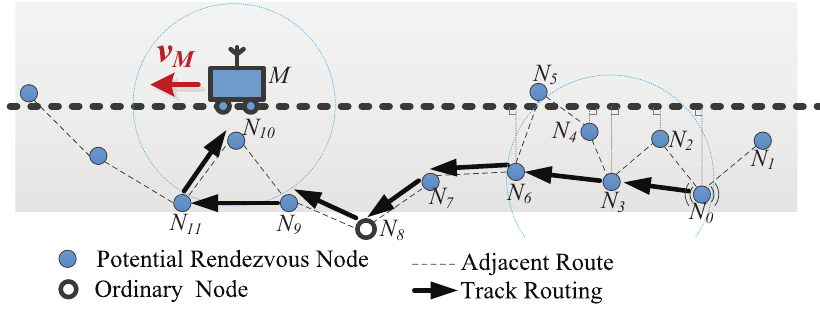
Figure 7. An example of the track routing in